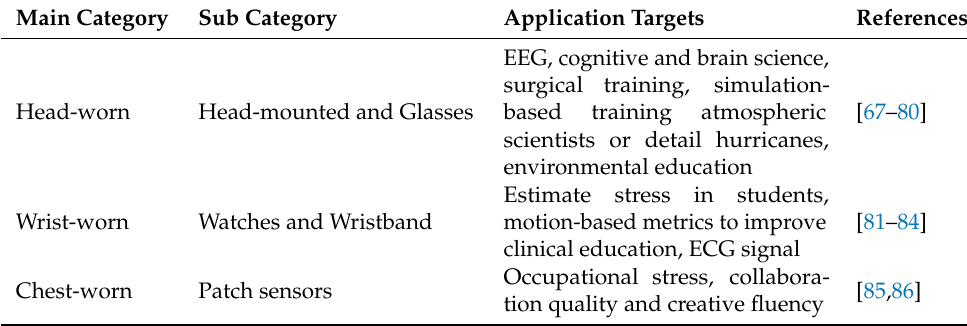
Table 3. Wearable devices in higher education and main features.